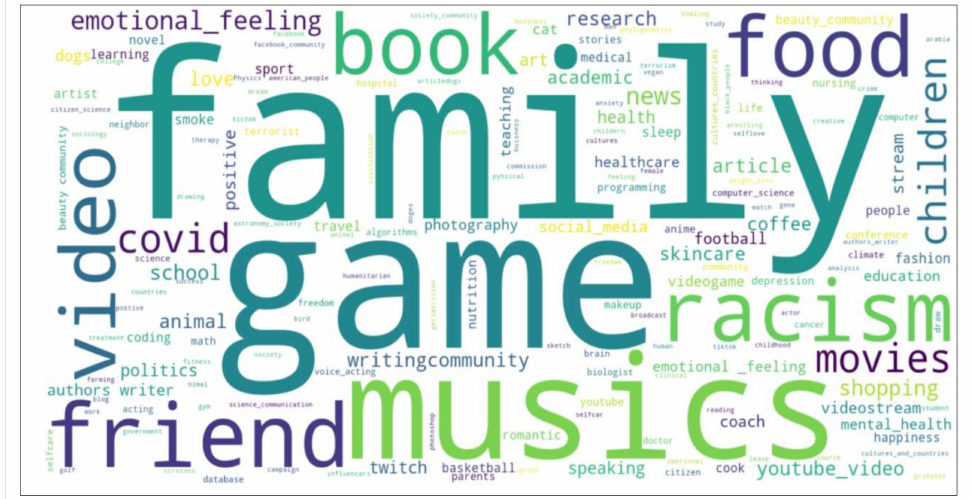
Figure 8. The Extracted LDA topics.